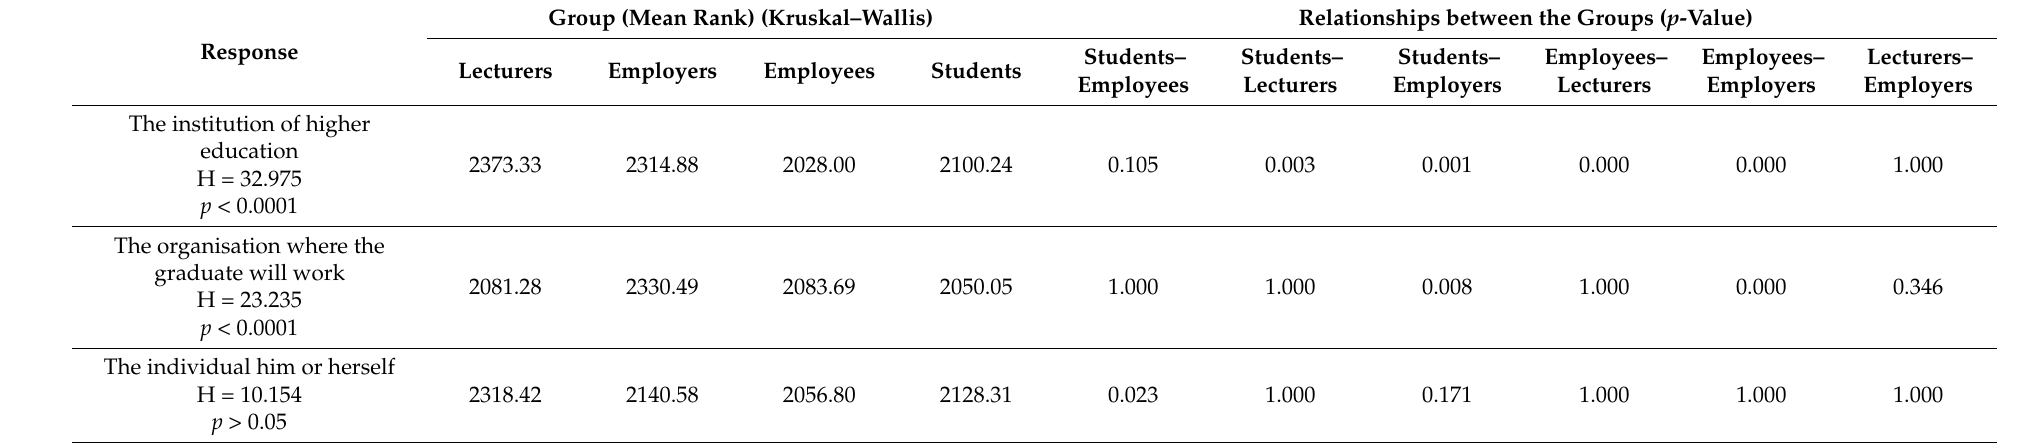
Table 10. Delegation of responsibility for developing a person’s critical thinking skills: comparison by